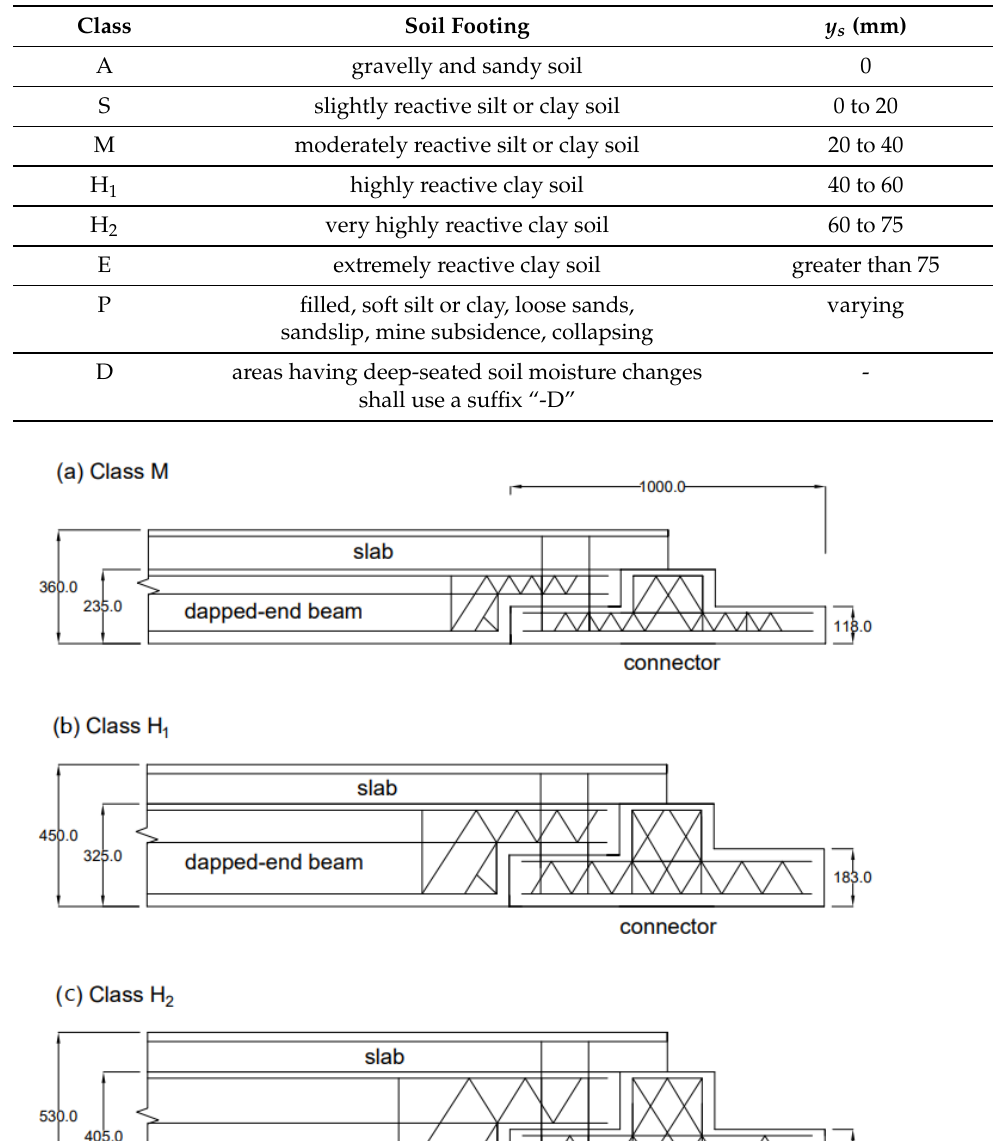
Table 1. Classification of site based on reactivity of soil and soil movement, y s , as described in the Australian Standard (AS) 2870-2011 [24].